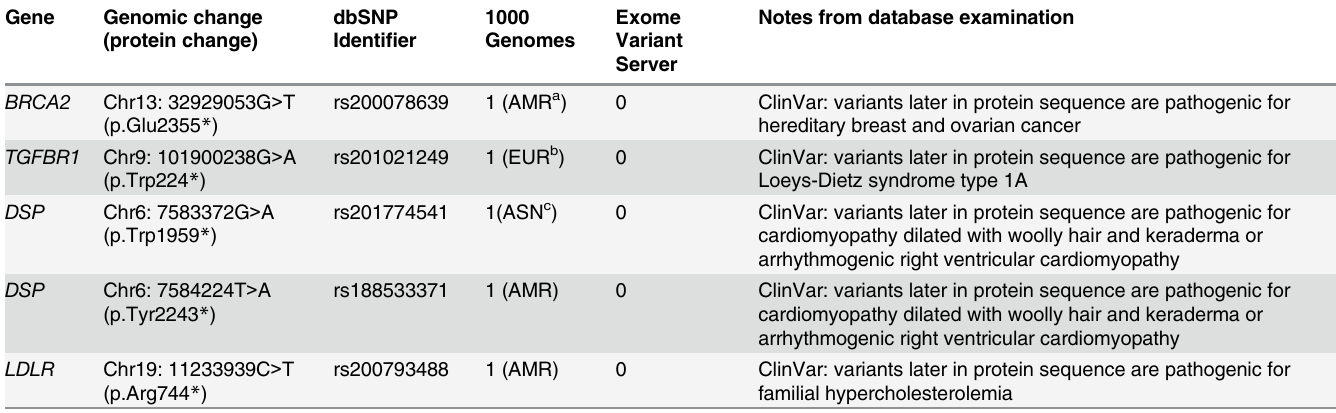
Table 4. Additional expected pathogenic variants that meet criteria for disclosure as secondary